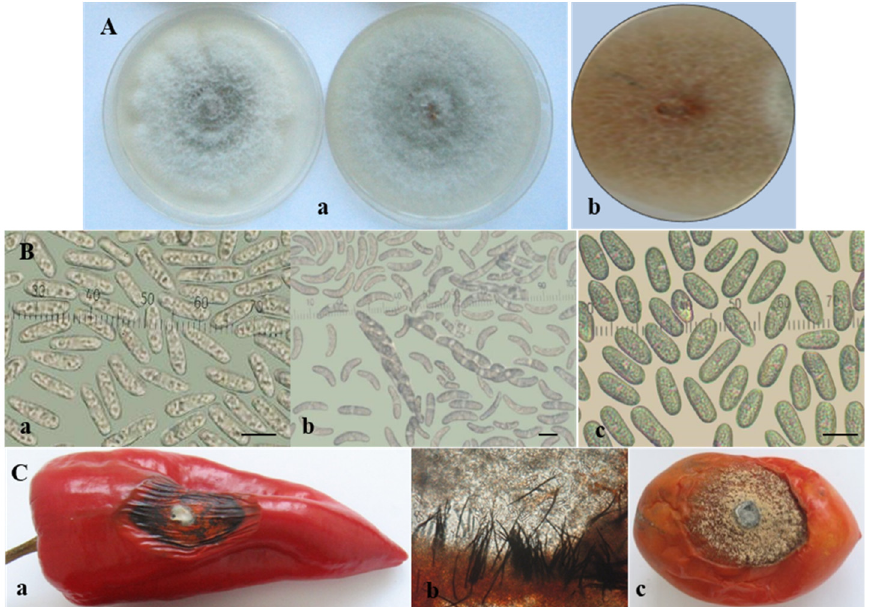
Figure 3. Colletotrichum gloeosporioides group . ( A ) Colony morphology of : C. cigarro ( a ) and C. musae ( b ); ( B ) sporulation: conidia ( a ) and ascospores ( b ) of C. cigarro; conidia of C. musae ( c ); scale bars = 10 µm; ( C ) advanced symptoms caused by C. cigarro (isolate CgD6-1) on artificially inoculated detached fruits of: pepper—( a ) dark dry wrinkled lesion; ( b ) black sporulating setose acervuli just beneath the skin of the infected fruit (×16) and ( c ) tomato.